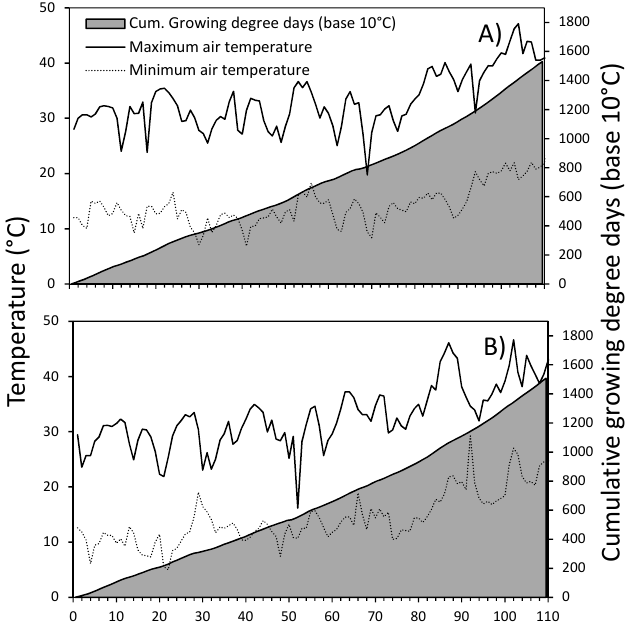
Figure 3. Actual maximum and minimum daily air temperatures with cumulative growing degree days, during experiments in 2015 ( A ) and 2016 ( B ).